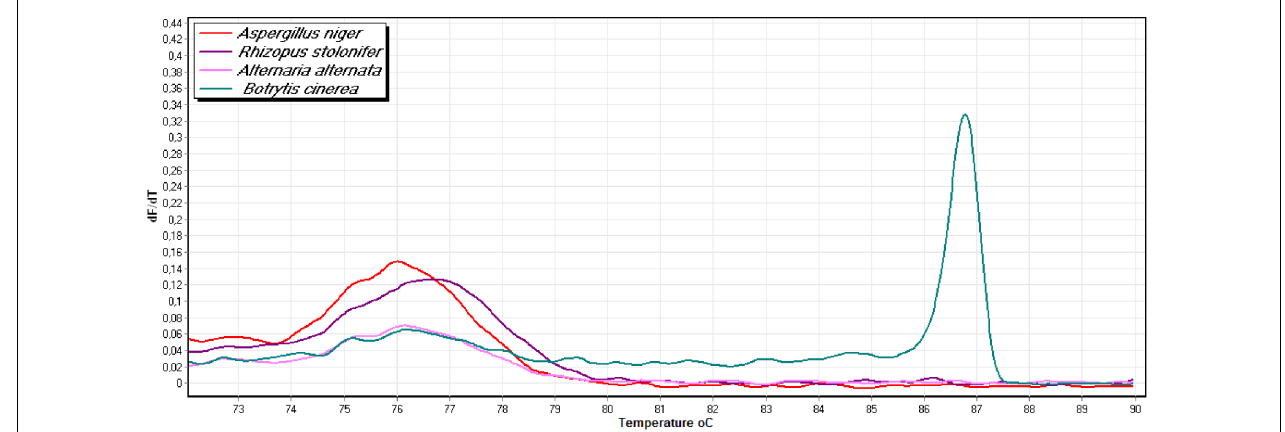
FIGURE 3 | Melting profile of four fungal pathogens, using the specific primers SDHB-Fw and SDHB-Rev with genomic DNA of B. cinerea, Aspergillus niger, Rhizopus stolonifer , and Alternaria alternata.